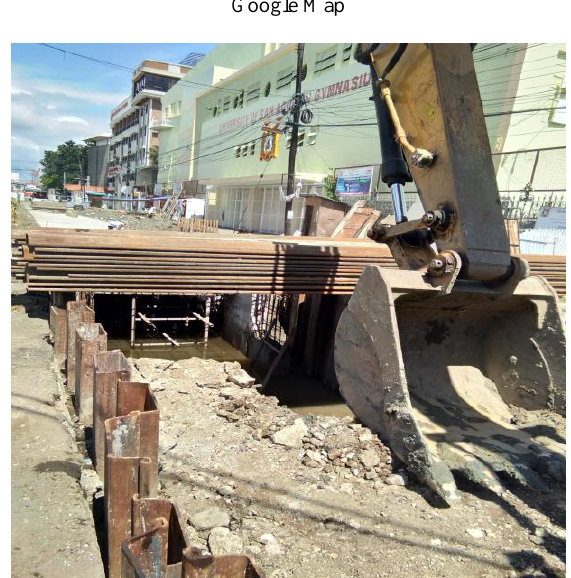
Figure 6. Culverts in Iloilo City being installed in a high flood risk area.